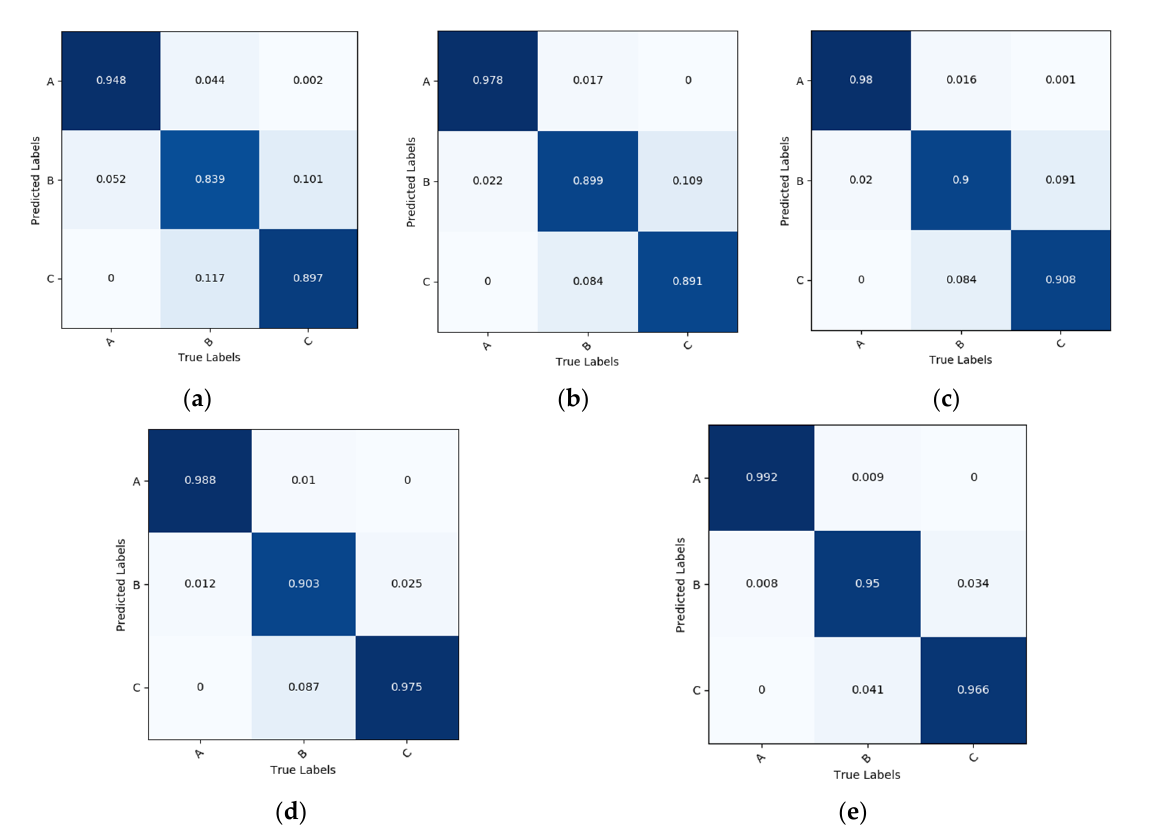
Figure 8. Confusion matrix of five models. ( a ) BPNN. ( b ) AlexNet. ( c ) VGG16. ( d ) ResNet34. ( e ) IRBOA.